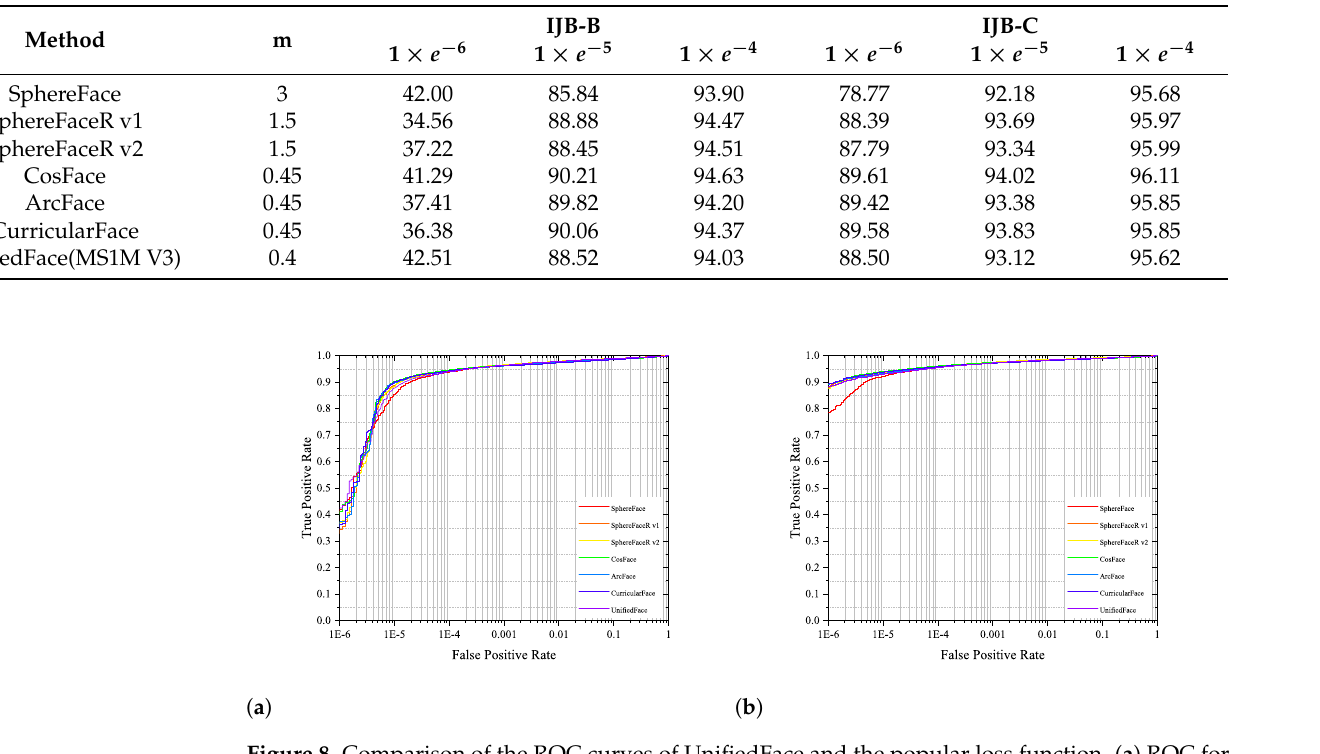
Figure 8. Comparison of the ROC curves of UnifiedFace and the popular loss function. ( a ) ROC for IJBB; ( b ) ROC for IJBC.